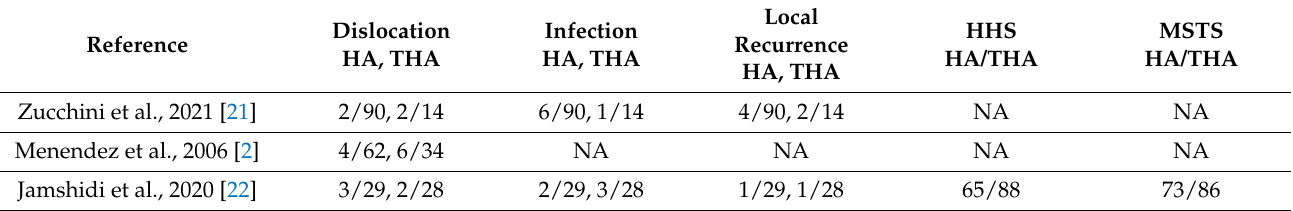
Table 2. Outcomes of the included